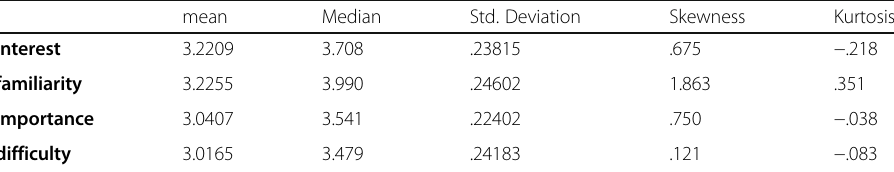
Table 5 Descriptive Statistics for Learners ’ Perception of the Textbook-Assigned Topics mean Std.